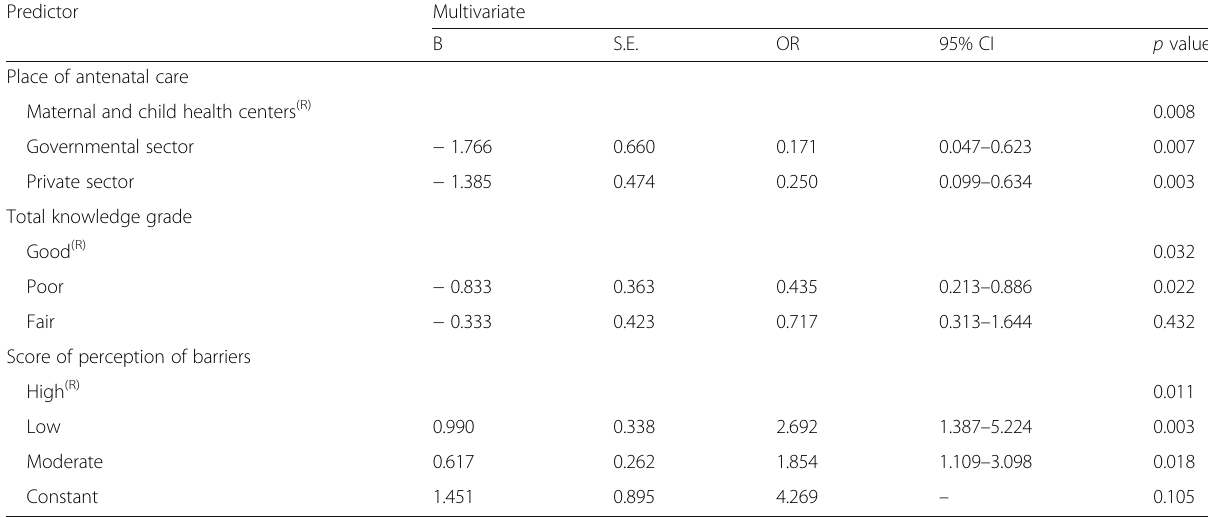
subtotal scores